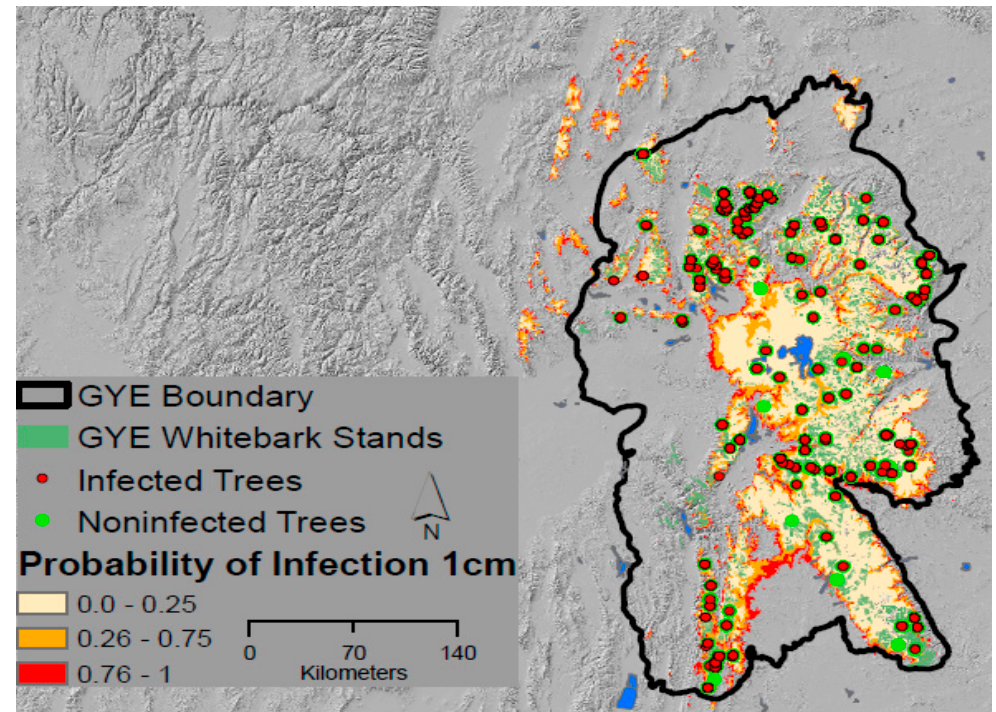
Figure 6. Probability of white pine blister rust infection in whitebark pine in the Greater Yellowstone Ecosystem created using the top model (m17) from Table 1. Probability is based on the interaction between August and September relative humidity (asRH) and temperature (asTEMP), modeled for a 1 cm DBH tree. The extent of modeled probability was limited to locations with mean August–September temperatures between 7.67 and 12.03 °C, the range of asTEMP from Daymet at the monitored stands.